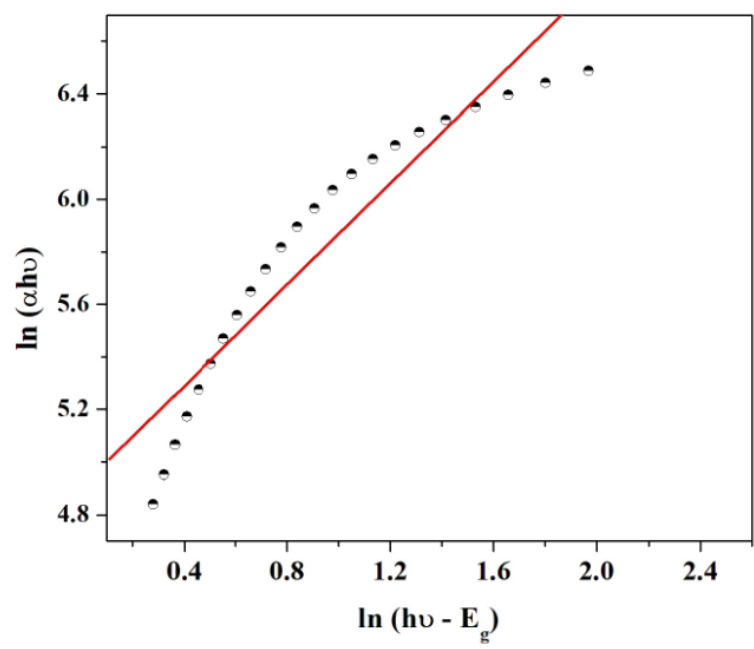
Figure 4. Plot of ln(hυ − E g ) versus ln (αhυ) .